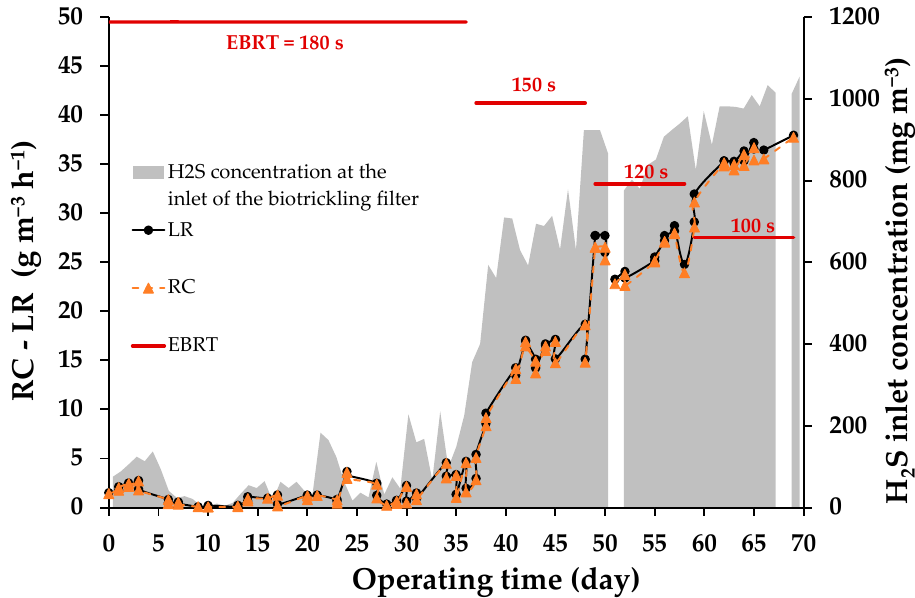
Figure 5. Loading rate (LR) and removal capacity (RC) of the biotrickling filter alone at different EBRT and H 2 S inlet